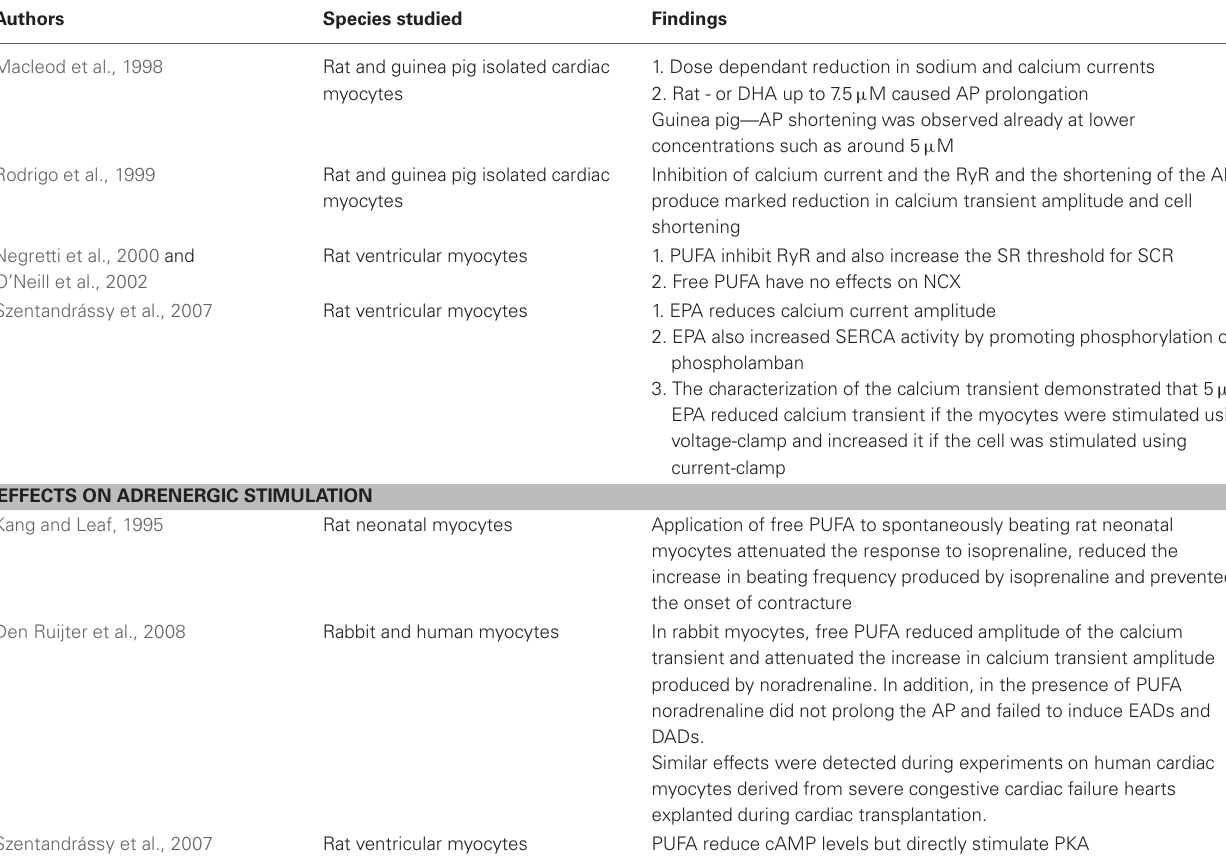
Table 1 | Summarising effects of free PUFA on myocardial calcium